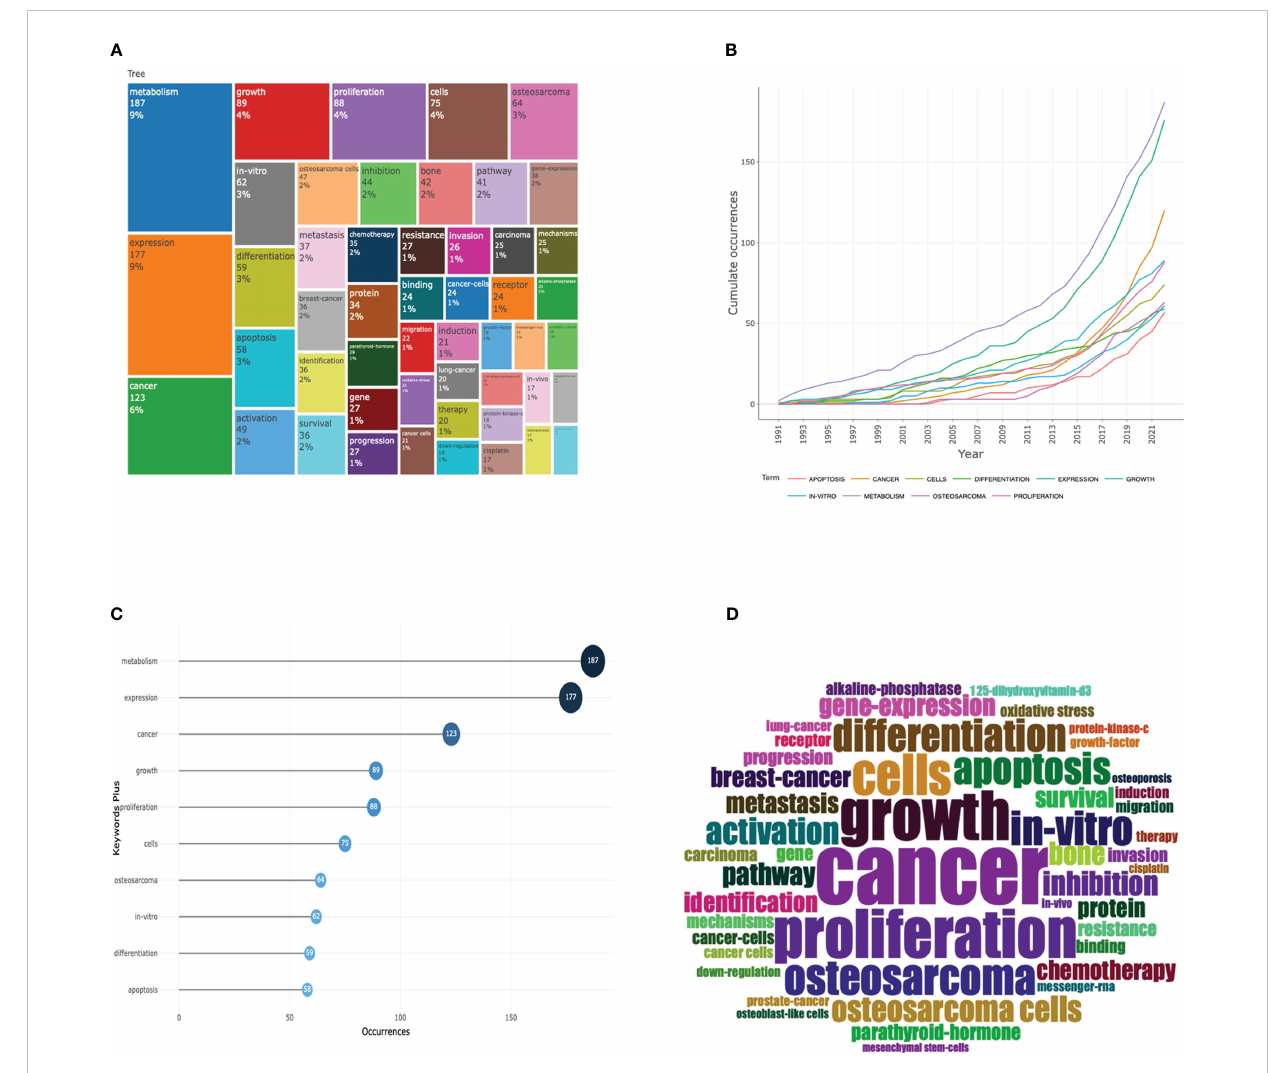
FIGURE 8 Analysis of keywords in the fi eld of osteosarcoma metabolism research. (A-D) are the keyword percentage, keyword trend graph over time, keyword hotness and intensity, and keyword tree graph,